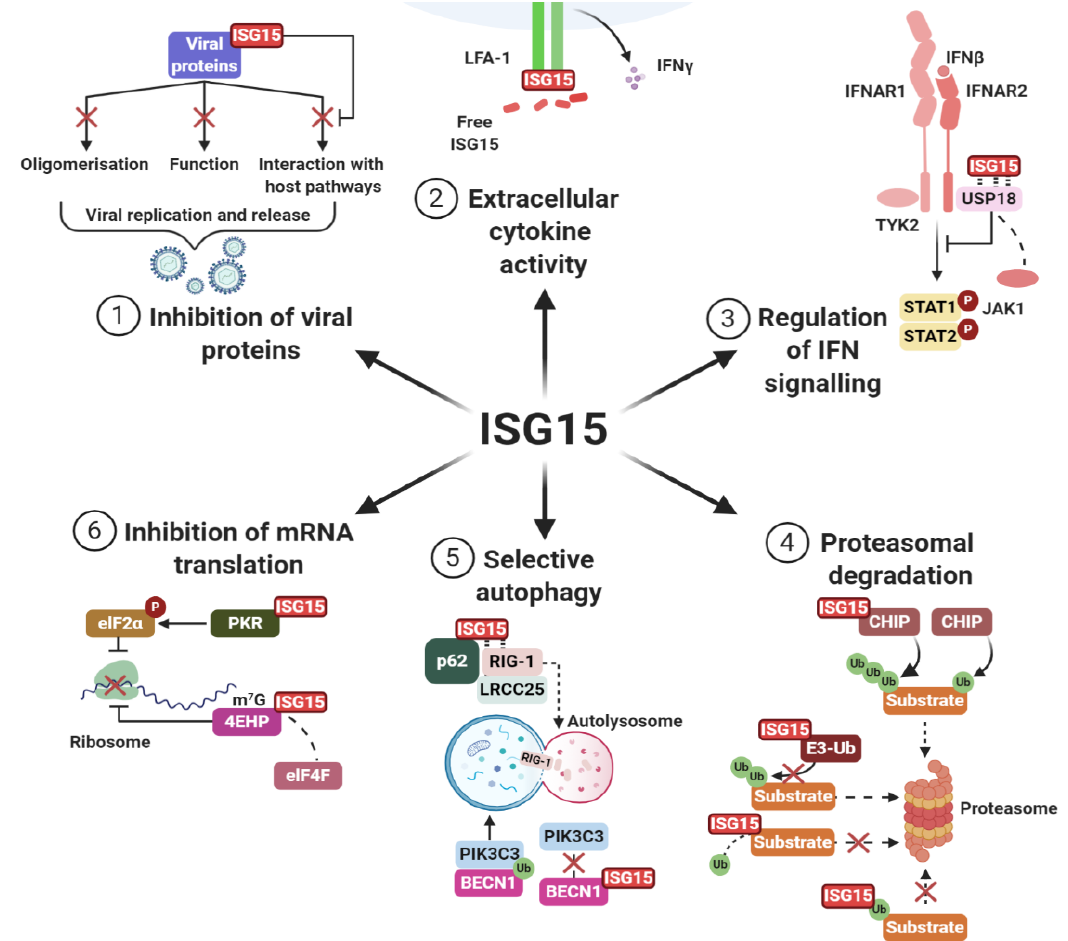
Figure 3. Canonical ISG15 functions in key cellular processes. (1) Inhibition of viral proteins. ISG15 modifies numerous viral proteins and is capable of disrupting their oligomerisation, function and interaction with host pathways. (2) Extracellular cytokine activity. Free ISG15 can be secreted as a cytokine and stimulate IFN γ release through interaction with the LFA-1 receptor. (3) Regulation of IFN signalling. The ISG15-protease USP18 interferes with type-I IFN signalling via direct interaction with the INFAR2 subunit of the IFN receptor. This displaces JAK1 and prevents JAK / STAT signal transduction. Non-conjugated ISG15 binds and stabilises USP18. (4) Inhibition of proteasomal degradation. ISGylation can interfere with ubiquitin-mediated proteasomal degradation through inhibition of E3 ligases, competition for lysine conjugation sites and formation of mixed chains. Alternatively, ISG15 can promote proteasomal degradation through stimulation of CHIP (aka STUB1) activity. (5) Selective autophagy. ISG15 can promote selective autophagy of target proteins. In the case of RIG-1, ISG15 association allows for interaction with LRCC25, facilitating p62-guided RIG-1 degradation via the autophagosome. Conversely, ISGylation of the autophagy-promoting protein BECN1 prevents its activity through disrupting its ubiquitin-mediated interaction with PIK3C3. (6) Inhibition of protein translation. ISGylation of PKR promotes phosphorylation and activation of the translational suppressor elF2 α . Similarly, ISGylation of 4EHP increases its a ffi nity to 7-methylguanosine mRNA cap binding, displacing elF4F and inhibiting protein translation. Figure created using BioRender.com (2020).